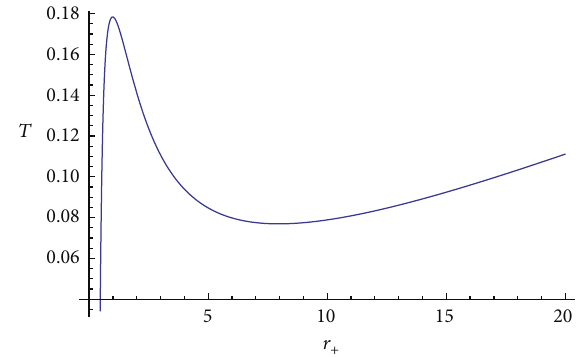
Figure 1: Plot of the Hawking temperature ( 𝑇 ) against horizon radius ( 𝑟 + ), for 𝛼 󸀠 = 0.5 , 𝑄 = 0.50 , and 𝑏 = 10 .